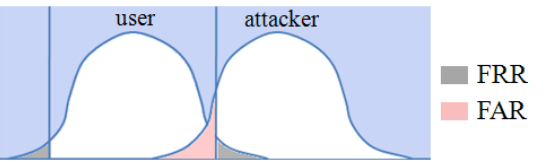
Figure 5. Performance metrics